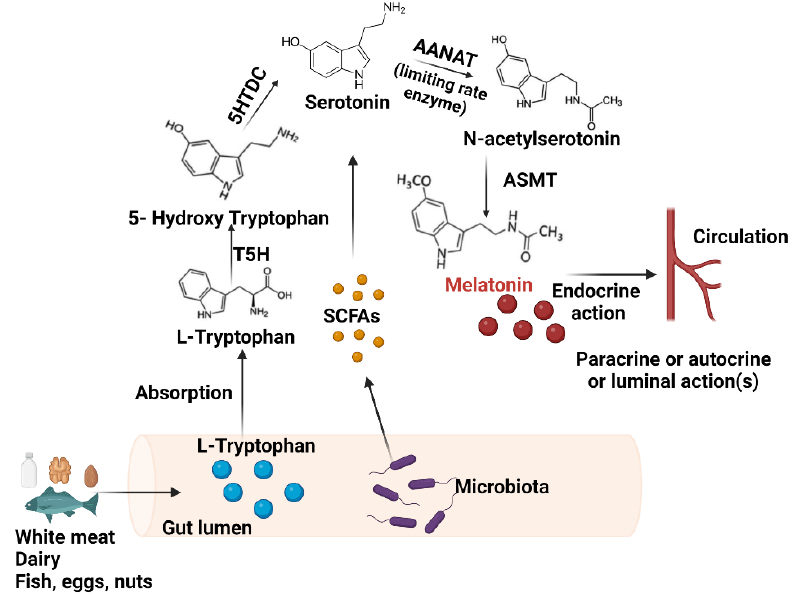
Figure 1. Melatonin biosynthesis in the enterochromaffin cells in the gut (arrows indicate the direction of the reactions). The synthesis starts with L-Tryptophan (Trp), which is first hydroxylated to 5-hydroxytryptophan, followed by decarboxylation to 5-hydroxytryptamine (5-HT/serotonin). The rate-limiting enzyme AANAT converts 5-HT into N-acetyl 5-HT in the following step, and then the ASMT enzyme finishes the synthesis with MT production. After synthesis, melatonin is released in the bloodstream or the gut lumen and exerts local and systemic effects. Tryptophan-enriched diets (e.g., white meat, dairy) or melatonin-enriched diets (e.g., fish, eggs, nuts) can increase the gut